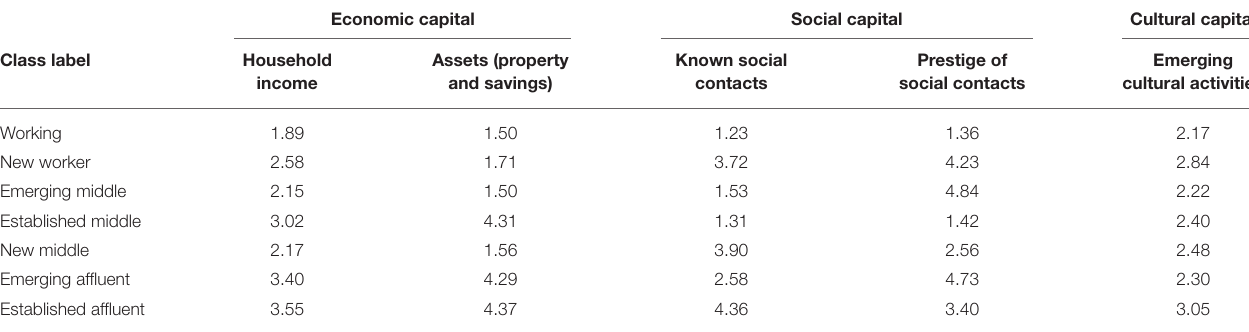
TABLE 1 | Marginal means of the variables used in the LCA by